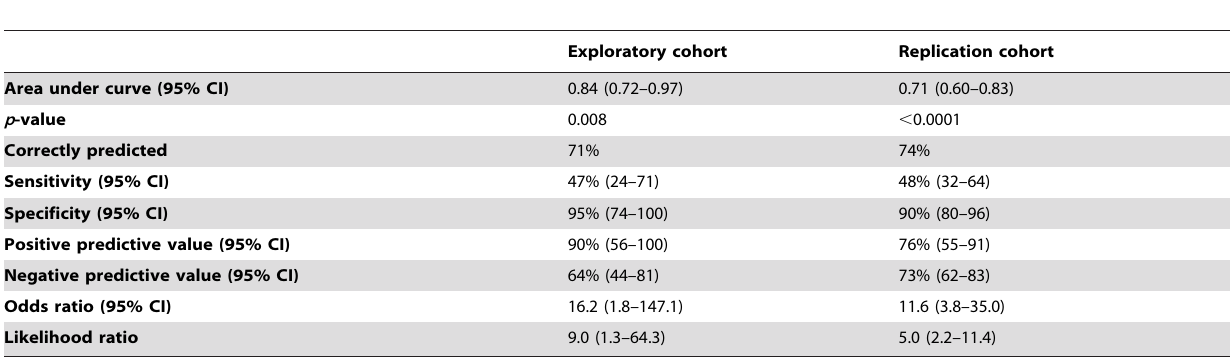
Table 3. Prediction potential of amniotic fluid cathelicidin cut-off level . 4.0 ng/ml for the presence of both MIAC and HCA in PPROM